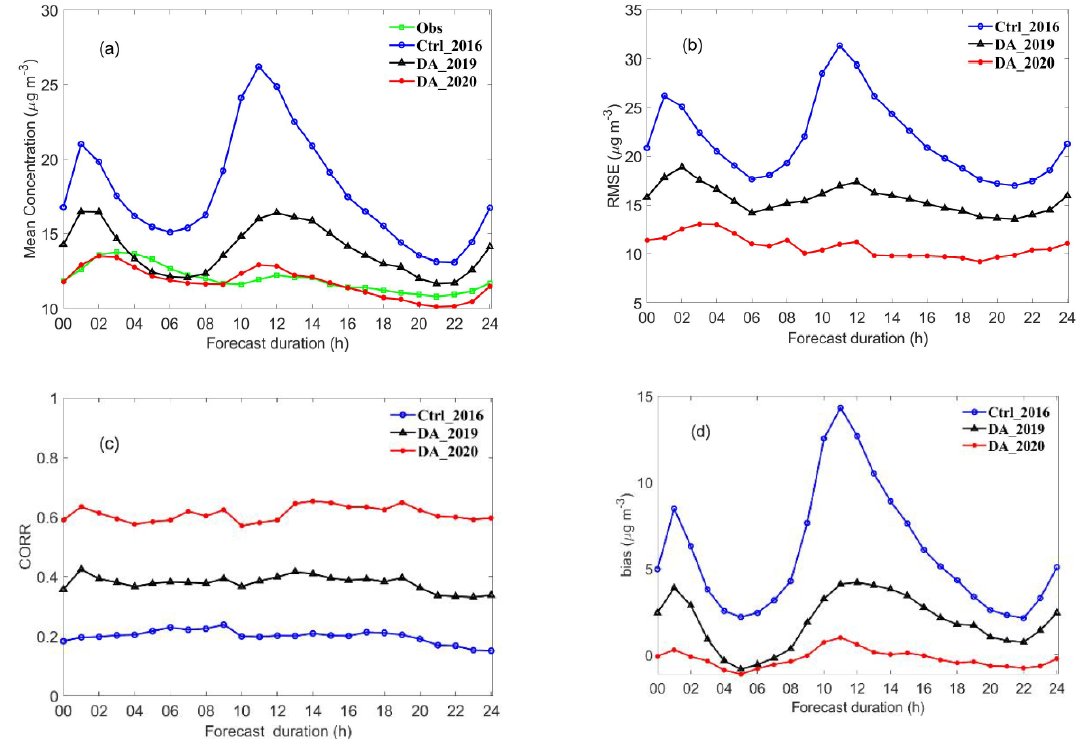
Figure 12. Forecast accuracy of SO 2 concentrations in China for the Ctrl_2016, DA_2019, and DA_2020 experiments during the study period in 2020: (a) mean concentration, (b) RMSE, (c) CORR, and (d) bias. Unit: µgm − 3 for (a) , (b) , and (d) . Obs: